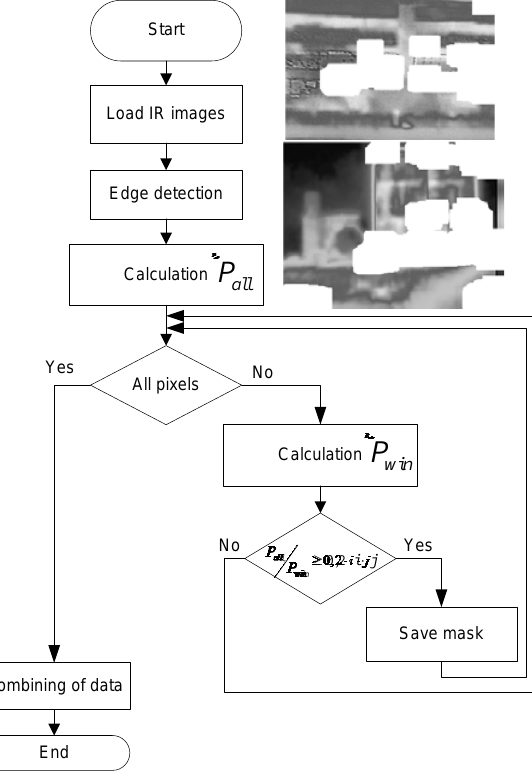
Fig. 2. The algorithm for finding areas of detail on the